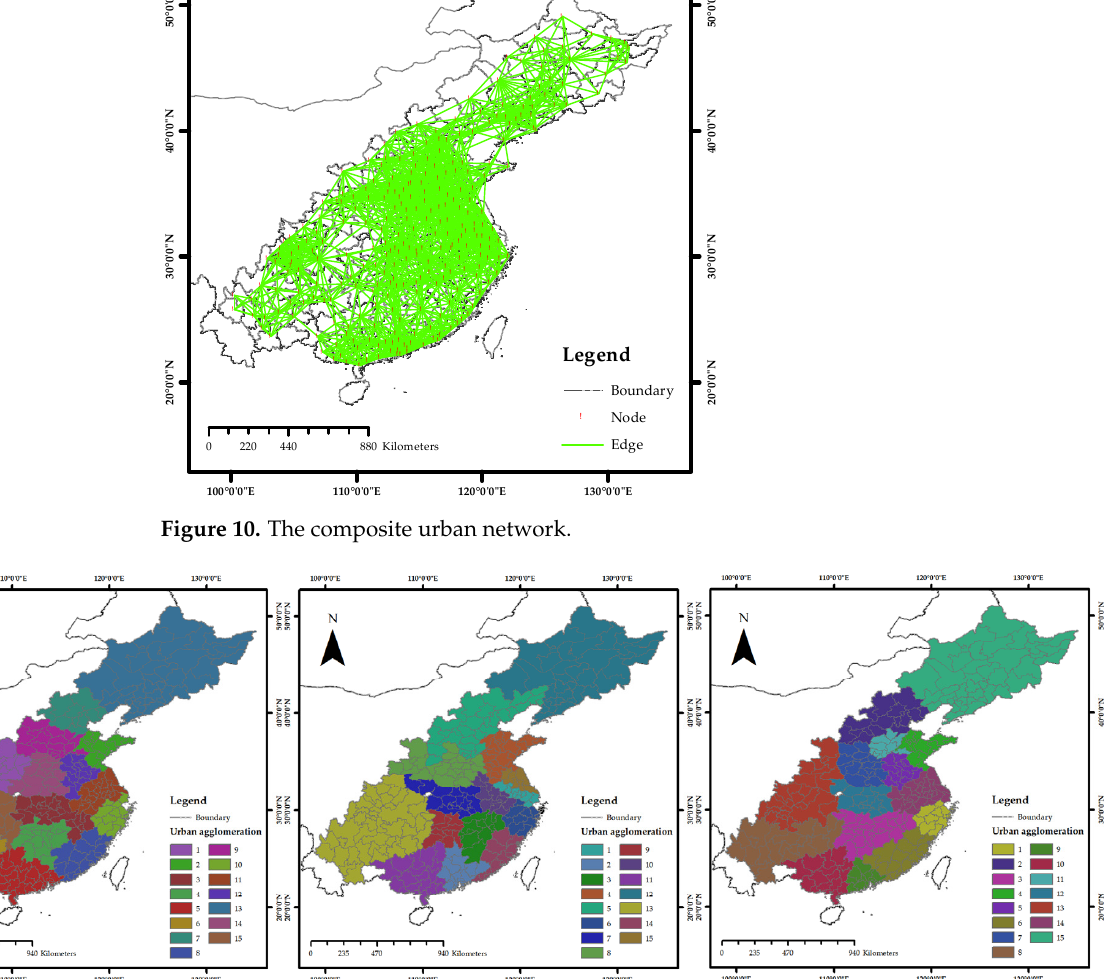
Figure 10. The composite urban network.